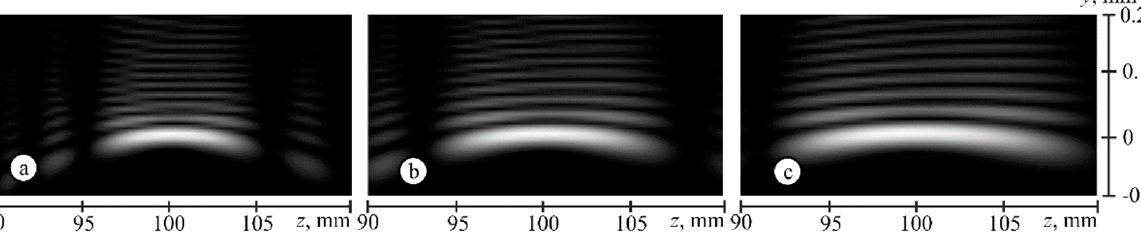
Figure 4. PSF longitudinal pattern for phase apodized lenses n = 5 ( z ∈ [90 mm; 110 mm], y ∈ [ − 0.1 mm; 0.2 mm]): α = 0.002 ( a ), α = 0.005 ( b ) and α = 0.01 ( c ) at the wavelength of the illuminating beam λ = 550 nm.